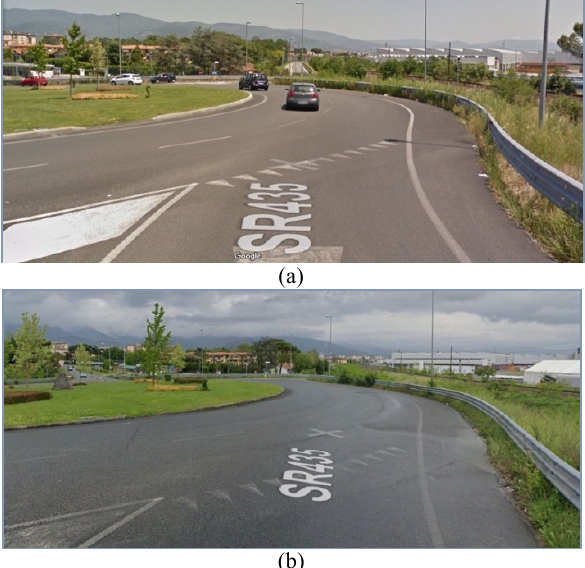
Figure 5. Roundabout condition, (a) in 2012, (b) in 2019